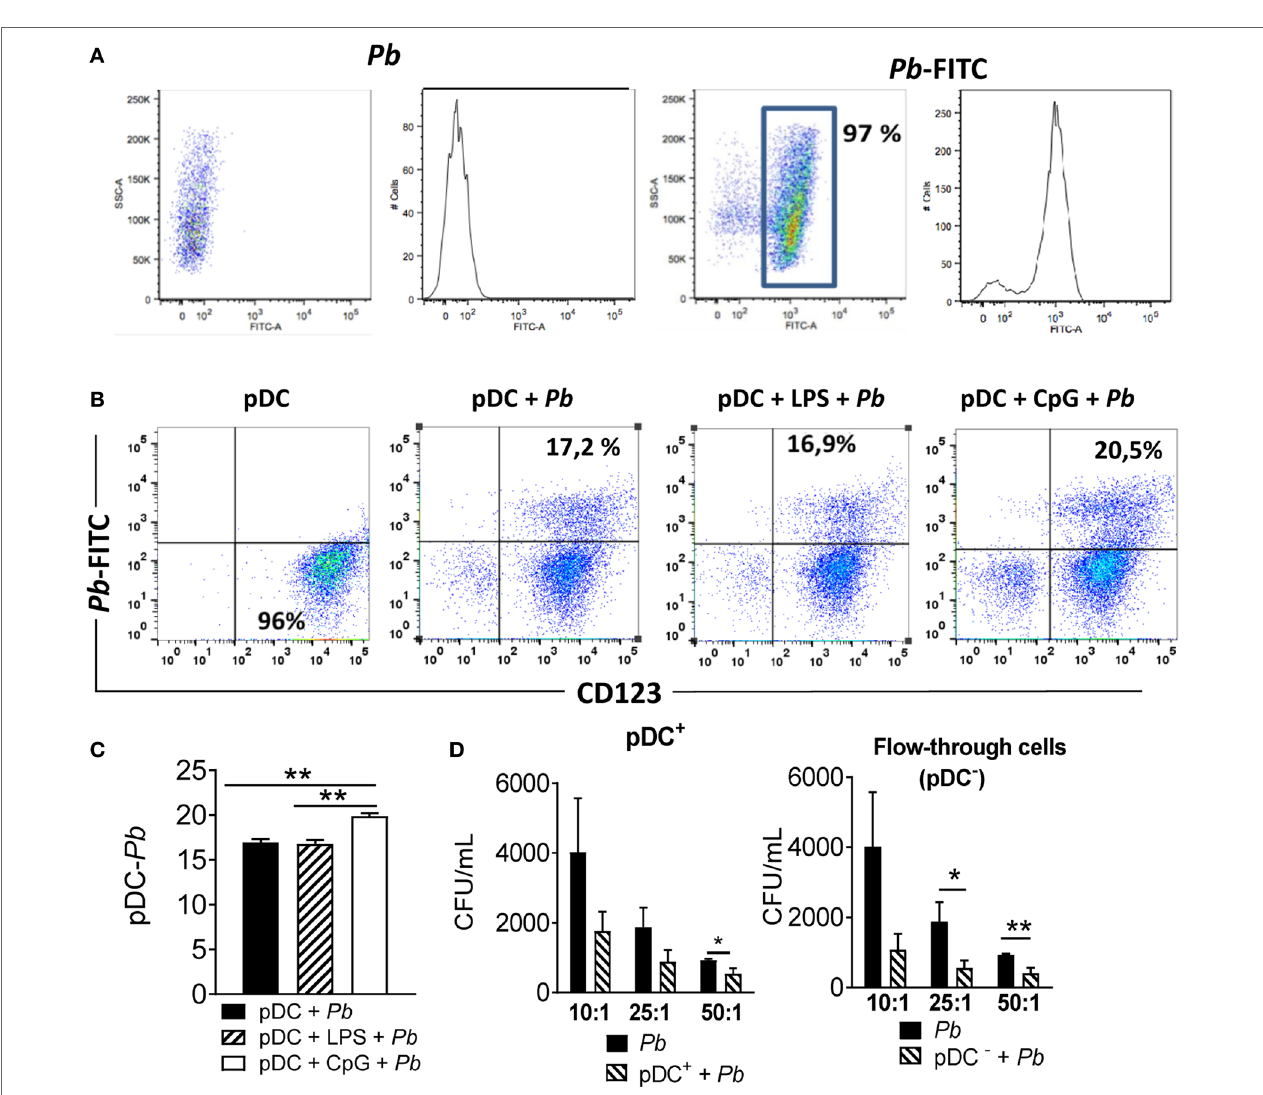
FigUre 1 | Plasmacytoid dendritic cells (pDCs) interact with and control Paracoccidioides brasiliensis growth. (a,B) Peripheral blood mononuclear cells (PBMCs) were separated into pDC positive (pDCs + ) using magnetic beads conjugated to an anti-CD304 antibody. The cells (2 × 10 5 /well) were challenged for 4 h with P. brasiliensis yeast cells (2 × 10 5 /well) previously labeled with FITC. Some wells were treated with CpG (100 ng/mL) or LPS (10 ng/mL) before the challenge. After 4 h of culture, the cells were labeled with an anti-CD123 antibody (specific to human pDCs) in the appropriate titration, and then 50,000 events were acquired by flow cytometry. (B) Dot plots are representative results for an experiment from three independents experiments. (c) Data represent means ± SE of the pDC– P. brasiliensis interaction from three donors, tested in triplicate ** p < 0.01. (D) For CFU analysis, PBMCs were separated into pDC-positive (pDCs + ) and pDC- negative (pDC − ) fractions using CD304-coated magnetic beads. The pDCs + and flow through-cells (1 × 10 5 /well) were then challenged with P. brasiliensis yeast cells in different ratios of pDC: Pb , such as 10:1, 25:1 and 50:1 (1 × 10 4 , 4 × 10 3 , and 2 × 10 3 yeasts, respectively). After 18 h of culture, the plates were centrifuged and the supernatant was collected for cytokine measurements by ELISA. The pellet was lysed and suspended in 200 µL of phosphate-buffered saline. Next, 100 µL was transferred to BHI medium and the colonies (CFU) counted for 15 days. Data represent means ± SE of CFU from four donors, tested in triplicate. * p < 0.05, ** p < 0.01, and *** p <